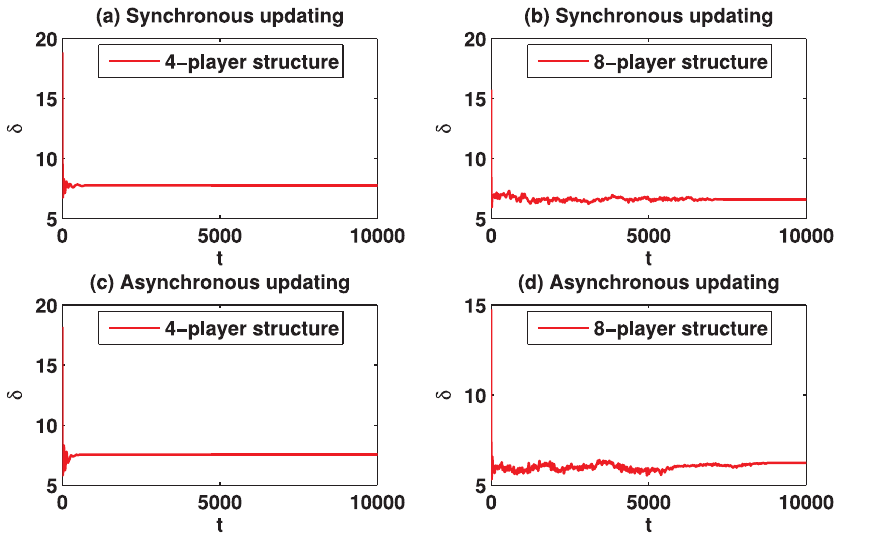
Figure 3. (Color online) Standard deviation of the strategies (denoted by d ) as a function of the evolution time on different square lattices under the best-take-over rule given that R ~ 10 . (a) Results on the square lattice with 4-player neighborhood and synchronous updating; (b) Results on the square lattice with 8-player neighborhood and synchronous updating; (c) Results on the square lattice with 4-player neighborhood and asynchronous updating; (d) Results on the square lattice with 8-player neighborhood and asynchronous updating.